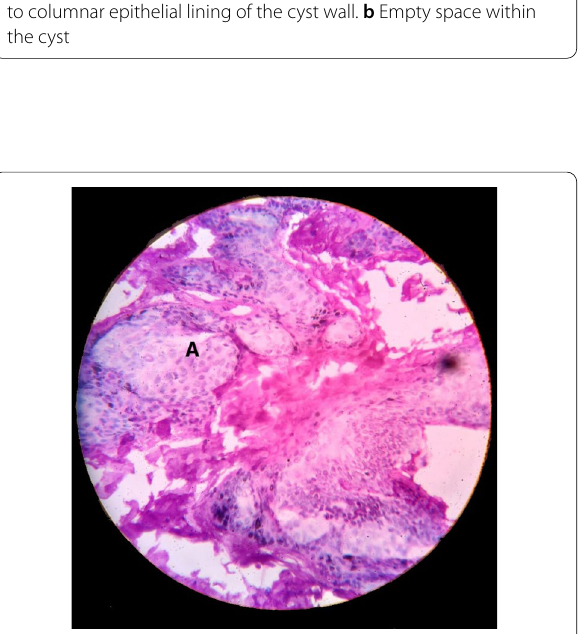
Fig. 12 H&E stain of Rathke’s cleft cyst showing squamous metaplasia within cyst wall lining as